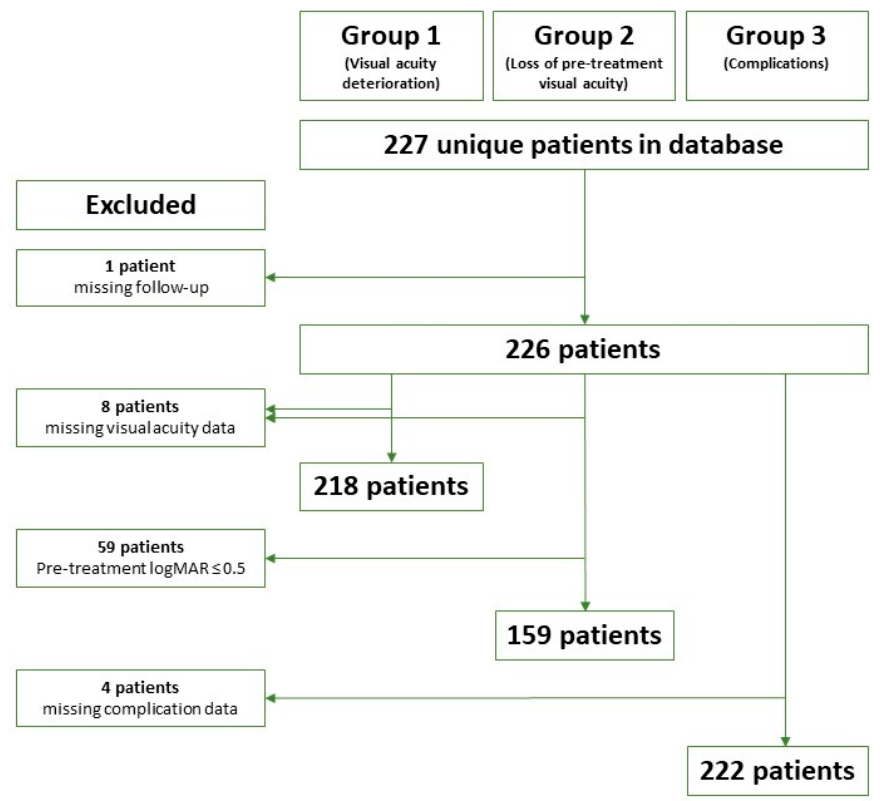
Figure 1. The patient selection process. LogMAR: logarithm of minimum angle of resolution.